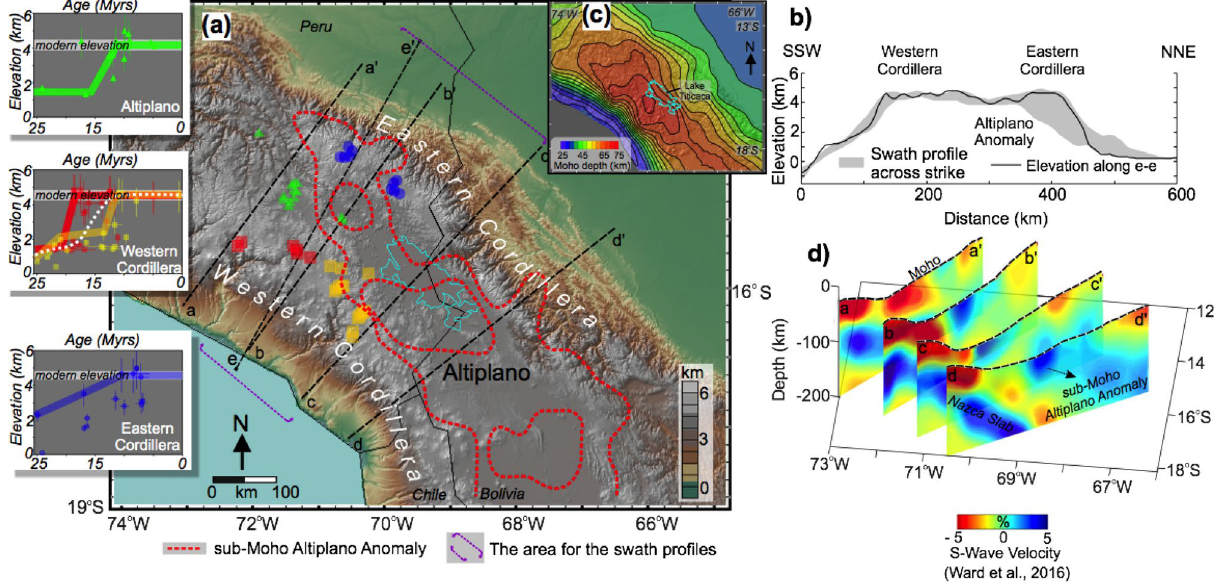
Figure 1. ( a ) Peruvian part of the Central Andean Plateau with topographic variations, including sub-Moho Altiplano Anomaly (thick dashed red line indicates the edge of fast seismic wave speed anomaly 18,19 ). Base map made with GeoMapApp (http:// www. geoma papp. org) 20 . Diagrams in the left edge of the map show the paleoelevation calculations (25–0 Ma) for Altiplano, Eastern and Western Cordillera 14 . While available paleoelevation estimates across the Peruvian Central Andes show spatial and temporal variations and a range of uplift amounts, the work by Sundell et al. collectively interprets the independent geological information, other published paleolevation and isotopic data to better approximate the topographic evolution of the region within the uncertainty of ~ 500 m. For example, there is estimated ~ 2 km of elevation gain in the Altiplano between 15 and 10 Ma ( b ) Topographic swath profile indicating minimum and maximum elevations for the area in ( a ). Black line shows the topographic cross-section along ( e – e ′ ). ( c ) Map of Moho depth 18 . ( d ) Four lithospheric- upper mantle scale cross sections perpendicular to the strike of the orogen, produced from seismic tomography models (S wave velocity) 18 (please see the map for their locations). Note the sub-moho Altiplano (higher speed) anomaly hanging in the middle of the profile. ( c , d ) is created through Matlab software version R2016b (https:// www. mathw orks.